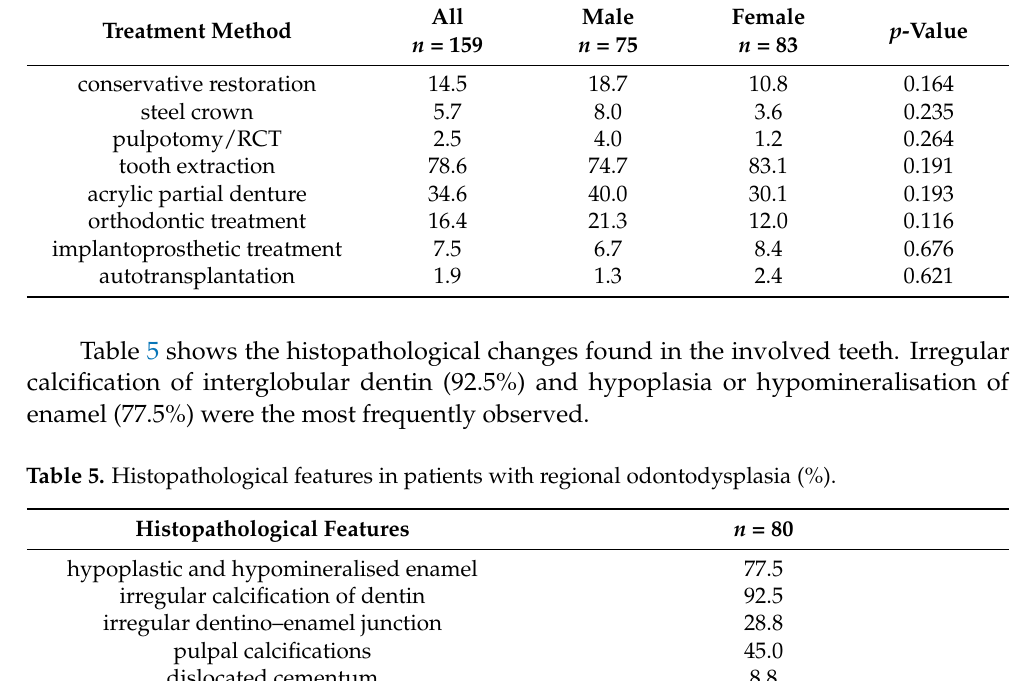
Table 4. Treatment methods in patients with regional odontodysplasia (%). Treatment Method